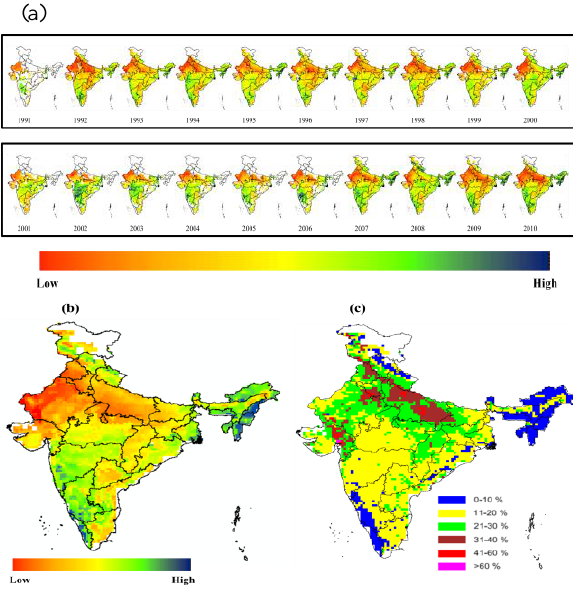
Figure 3: a) June month’s mean soil moisture images for 20 years, 1991-2000, b) 20-year mean soil moisture of June, and c)